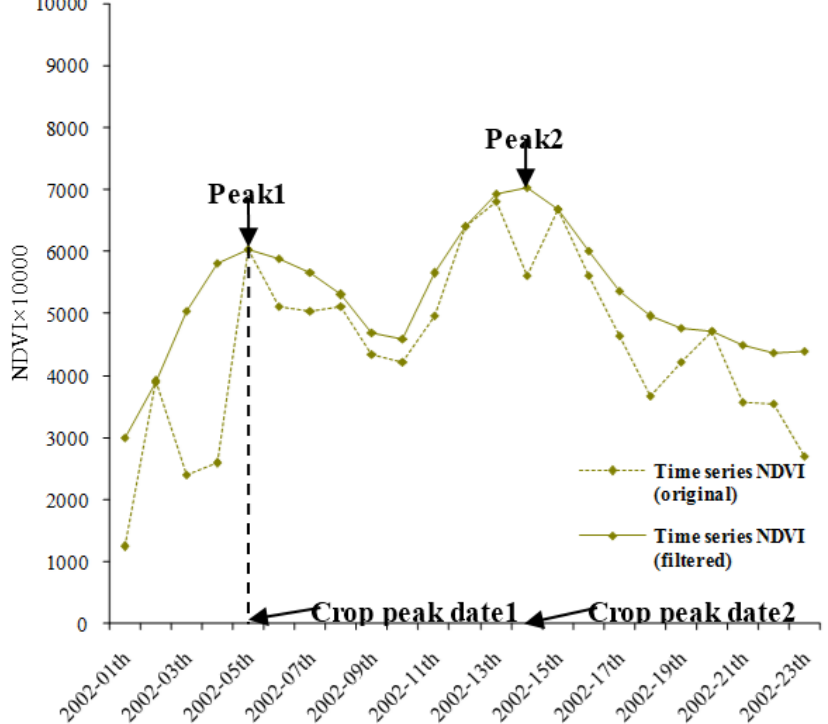
Figure 5. The illustration for presenting cropping intensity and crop peak dates in the study. The 2002-01th on the horizontal axis indicates the first composite in 2002, and so